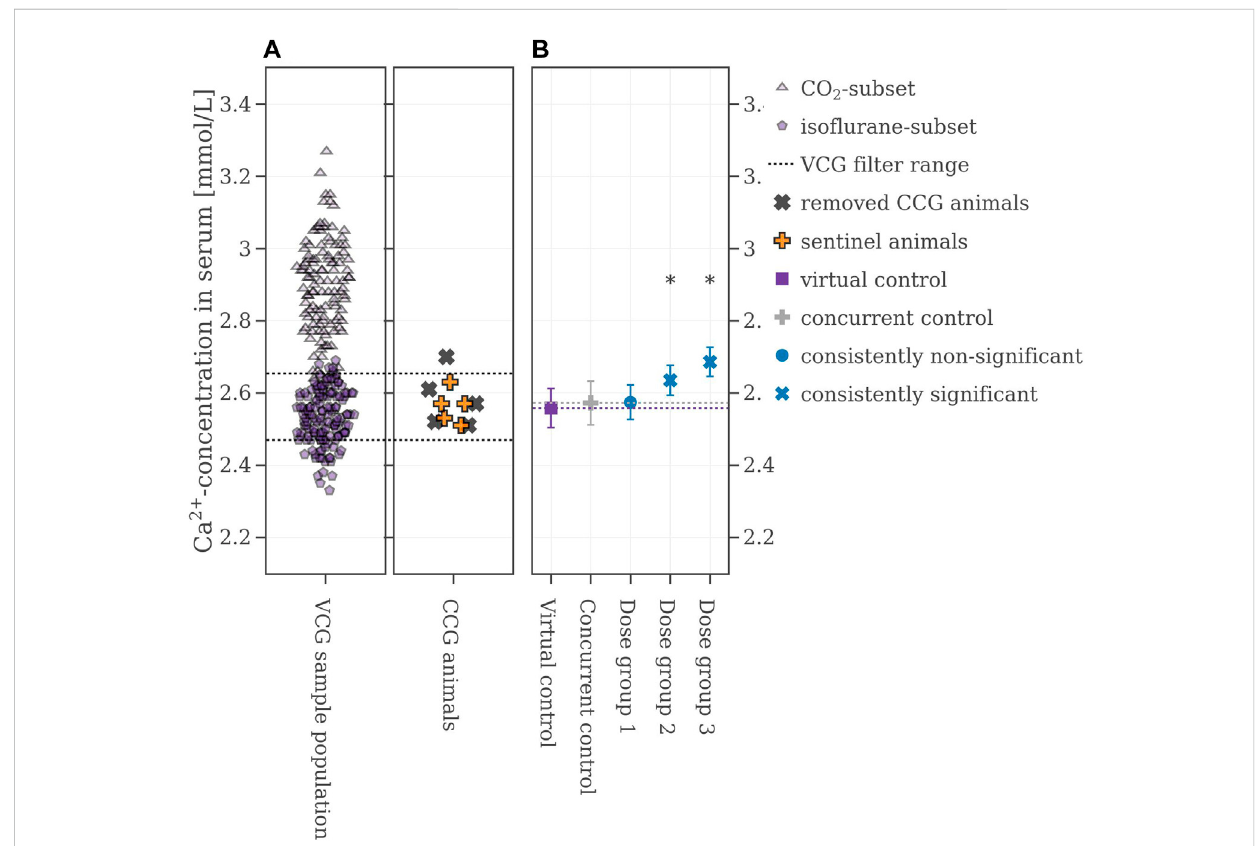
FIGURE 7 (A) Selection range of virtual control values along with concurrent control values which are removed and kept respectively. (B) Mean values of the legacy study and the virtual control, colored with respect to whether the original statistical results were reproduced or not. If the mean difference between a dose group and the virtual control exceeded the Dunnett-critical distance, the group was marked with an